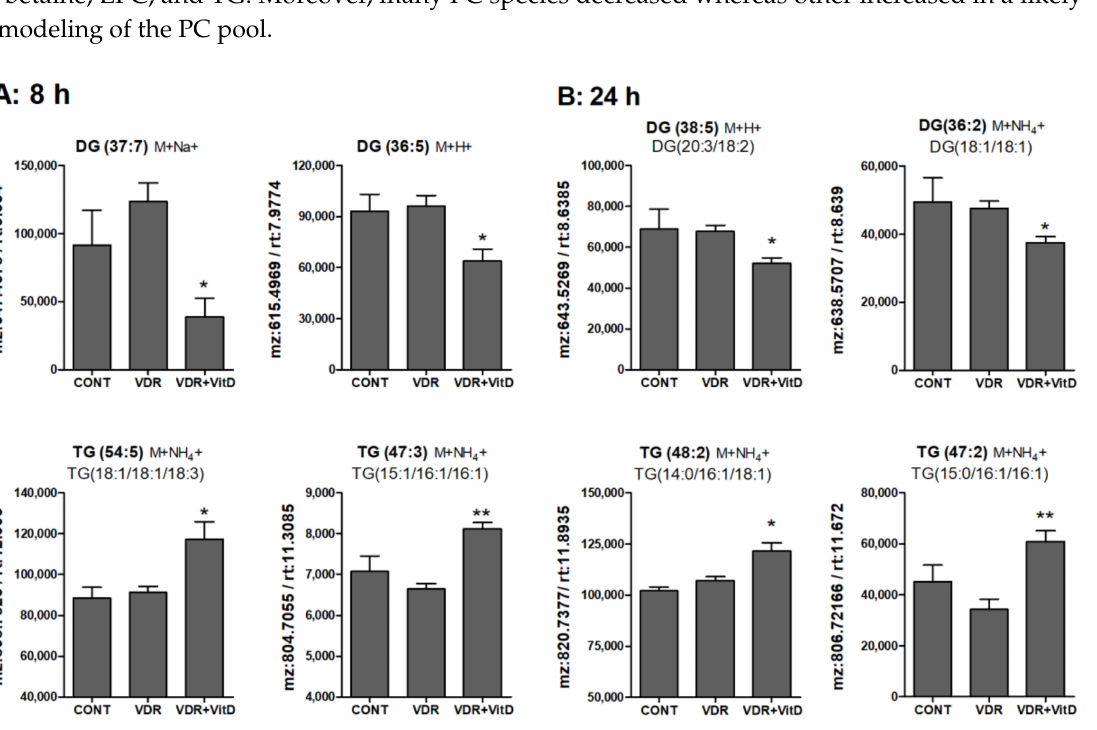
Figure 6. Relative intracellular levels of selected TGs and DGs in cultured human hepatocytes exposed to VitD. Upcyte hepatocytes were transfected with an insertless adenovirus Ad-C or with Ad-VDR for 48 h. Then, 10 nM VitD (VDR + VitD, n = 4) or vehicle (CONT, n = 3 and VDR, n = 4) were added for 8 ( A ) or 24 h ( B ). Cells were washed, and intracellular metabolites extracted and analyzed